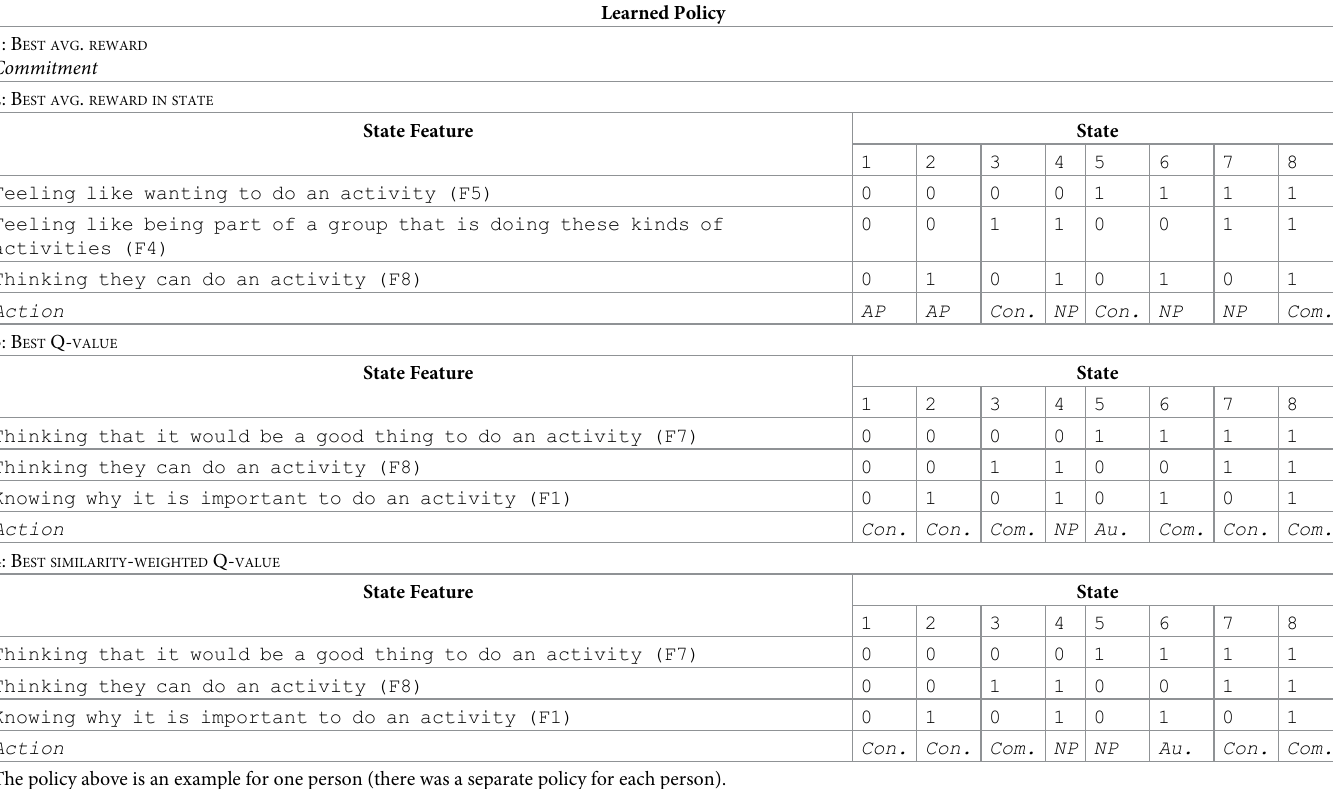
Table 5. The learned policy used in sessions 3–5 for each algorithm complexity level. The state feature selection and training of all policies were based on the data gath- ered in sessions 1 and 2 for the first batch of people ( N = 516) who successfully completed session 2. This training set of 516 samples was not updated thereafter as more data was